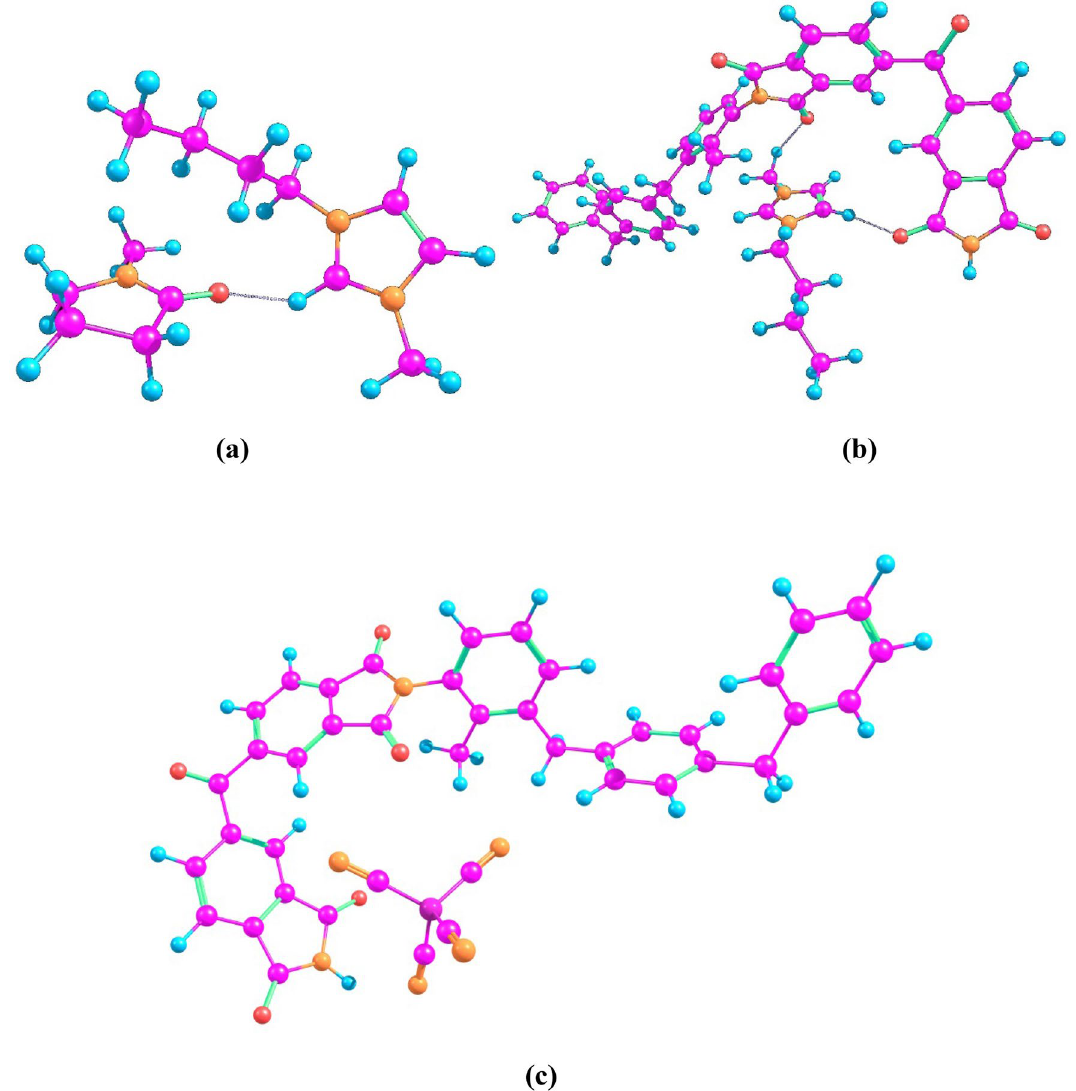
Figure 4. Scheme of coordination of ( a ) IL cation with NMP, ( b ) IL cation with P84, and ( c ) IL anion with